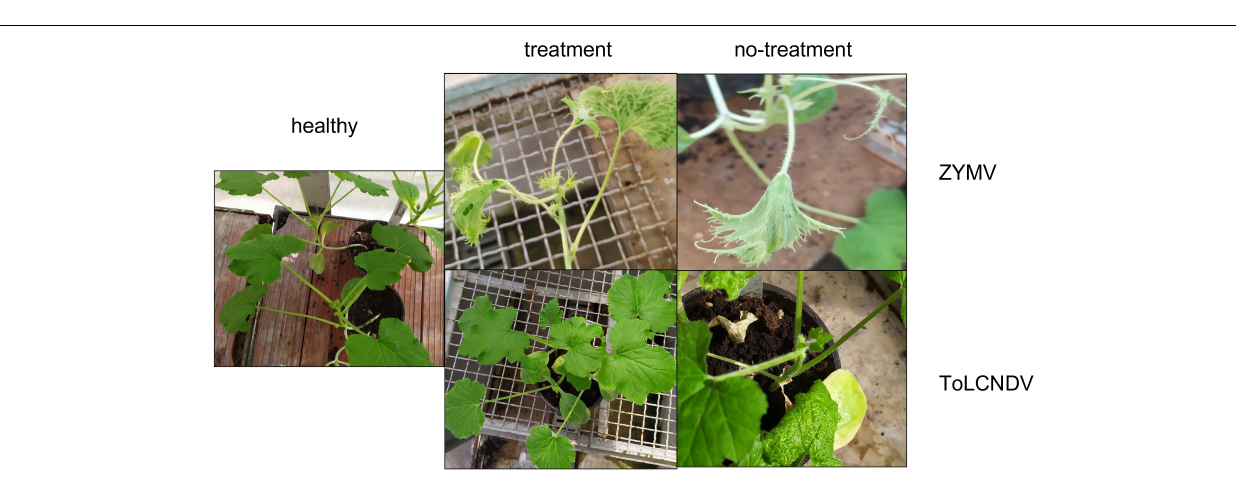
FIGURE 2 | Fold change of ToLCNDV-A in plants treated together with inoculation (A) and treated after inoculation (B) of ToLCNDV on leaves harvested at 5, 12, 19, and 26 d.p.i. OV EO, O. vulgare essential oil; TV EO, T. vulgaris essential oil; RO EO, R. officinalis essential oil; OV HS, O. vulgare hydrosol; TV HS, T. vulgaris hydrosol; RO HS, R. officinalis hydrosol; Rib ribavirin. Columns represent mean value from 2 technical replicates on 3 pooled biological replicates and bars indicate standard error ( ± SE).